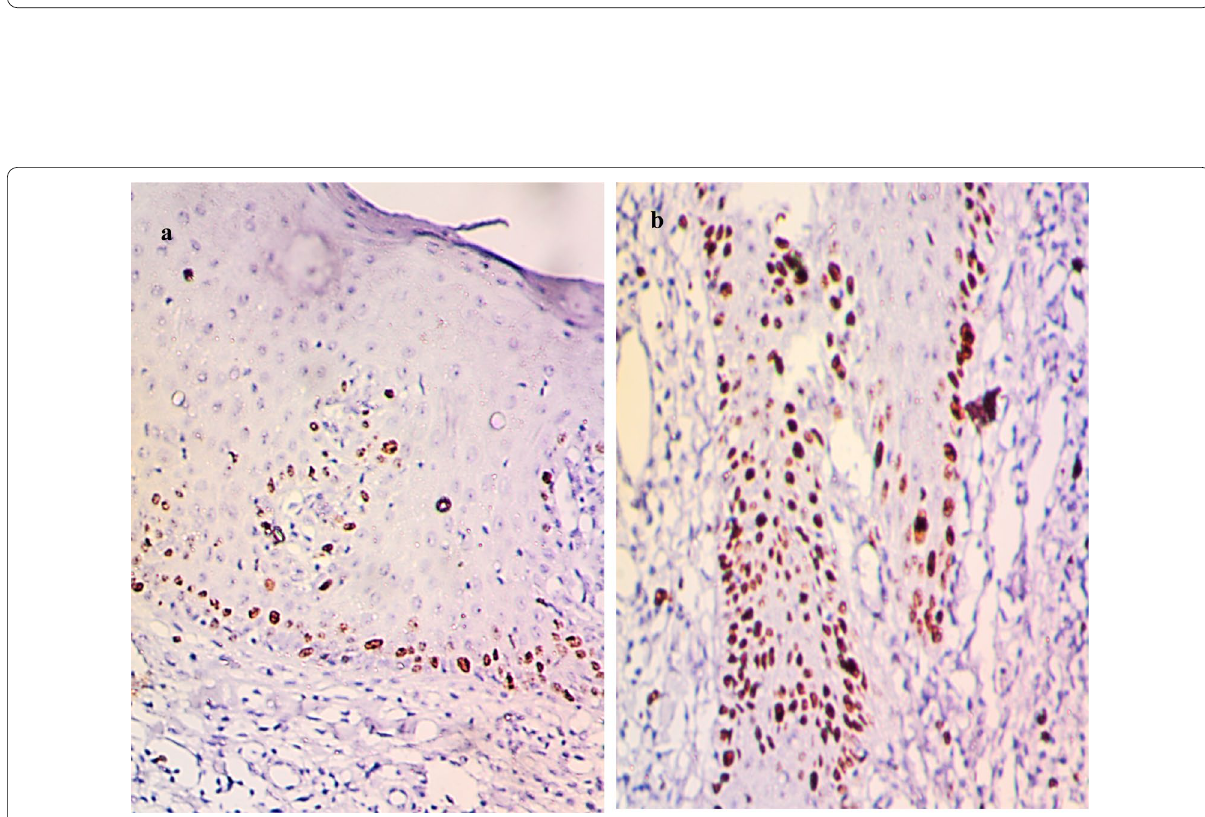
Fig. 2 Photomicrograph showing a negative expression of TNF-α in epithelium, b sporadic spots of weak expression of TNF-α in stroma (